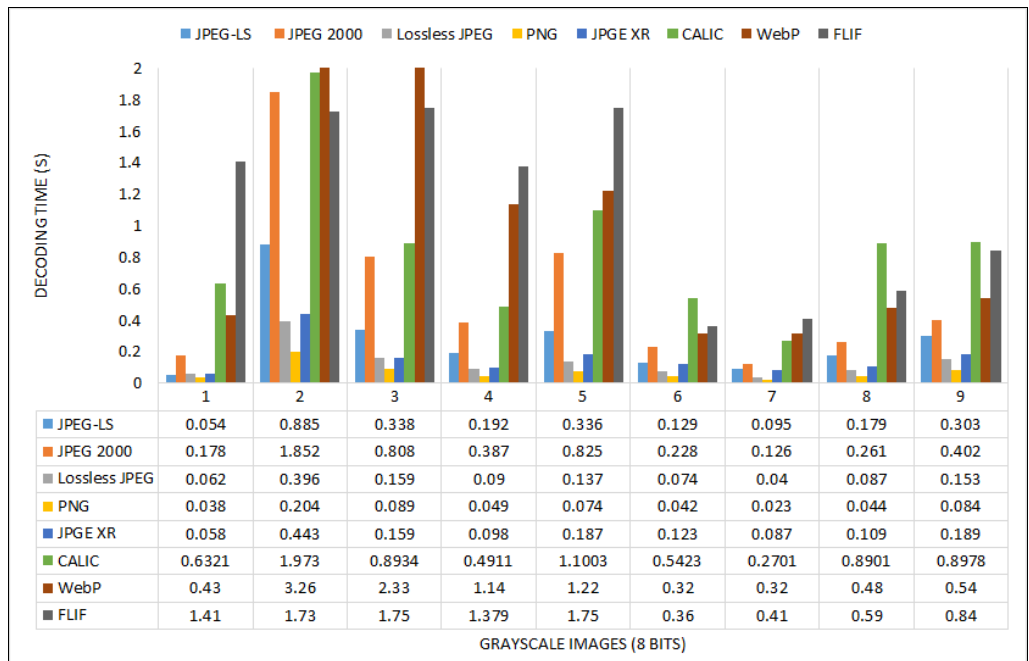
Figure 16. Decoding times for 8-bit greyscale images.